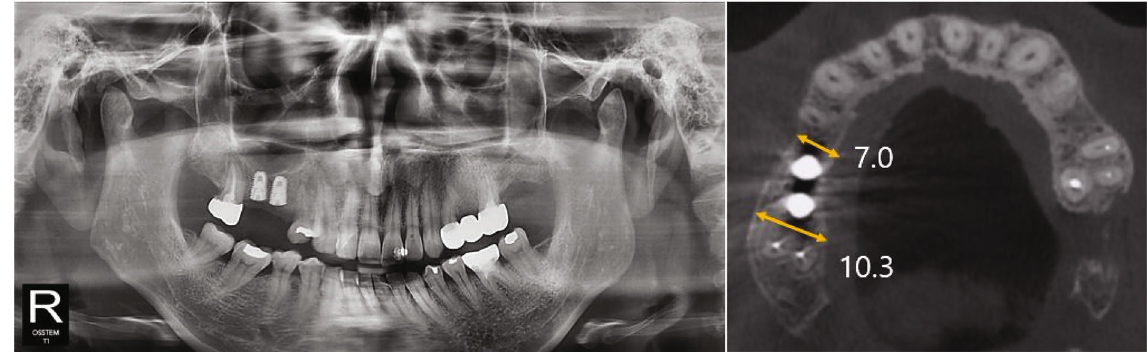
Figure 12: Post-implantation radiograph views (Case 3). The width of the alveolar bone was well-maintained, and the implant was placed. Table 1: Comparison of alveolar bone widths before and after surgery. There was some resorption, but as a result, it can be seen that the width of the alveolar bone increased after ridge splitting and expansion technique.